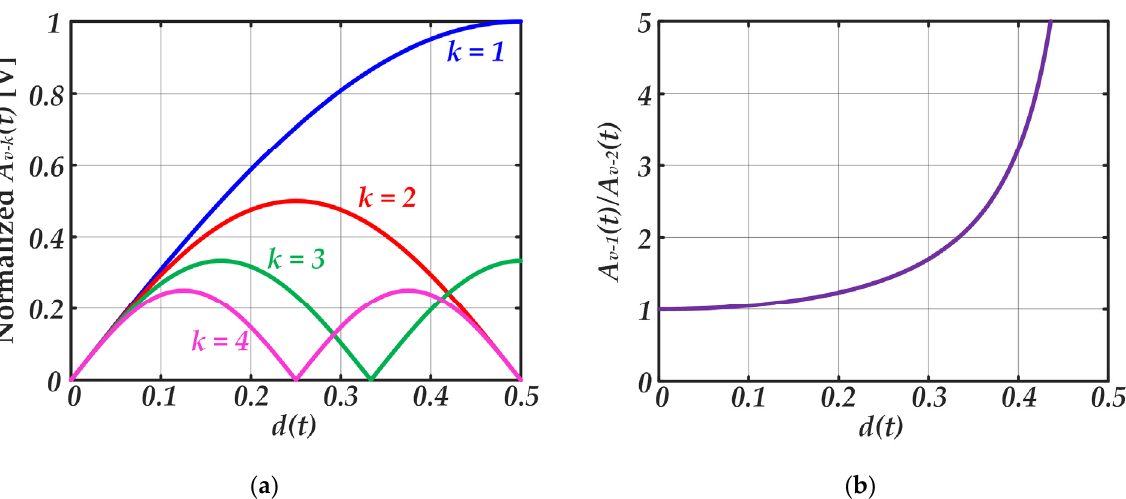
Figure 10. Analysis of the pulse-width modulation impact on the harmonics amplitudes: ( a ) Amplitude modulation of each harmonic versus d ( t ). ( b ) Ratio between the amplitudes of the first and the second harmonic.